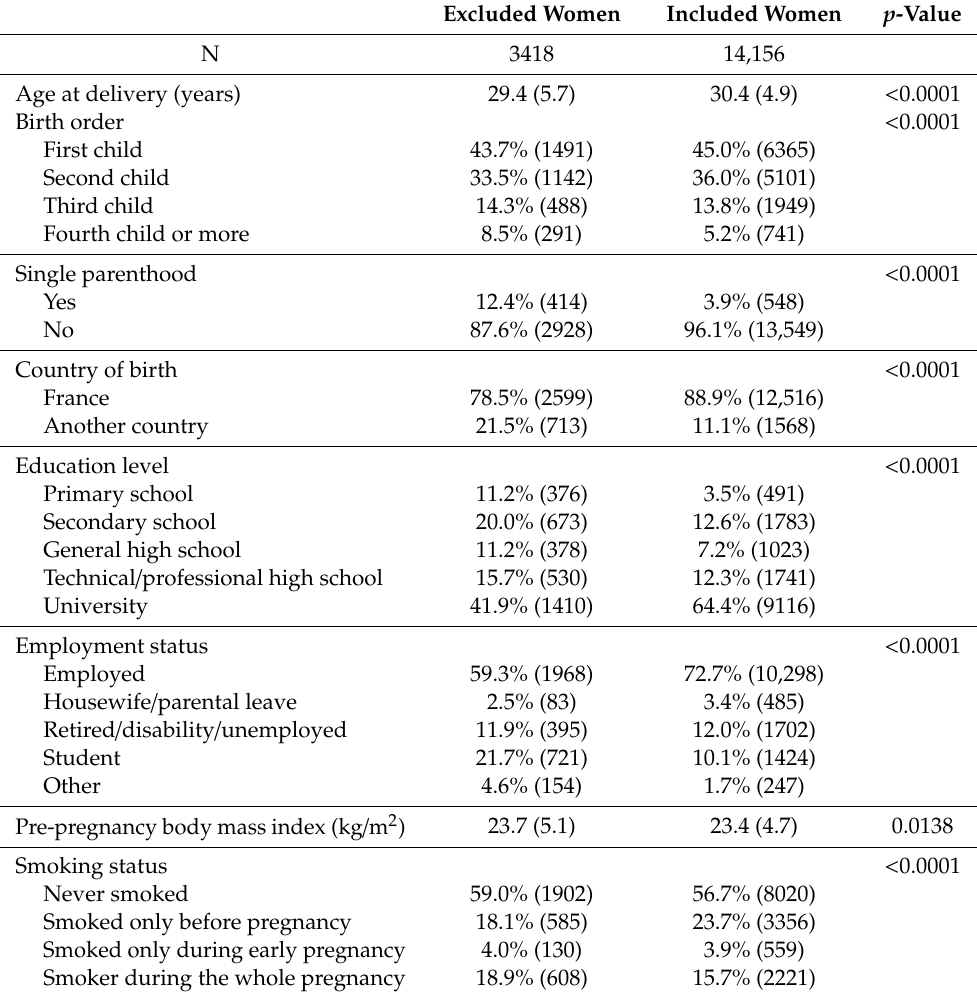
Table 1. Study sample